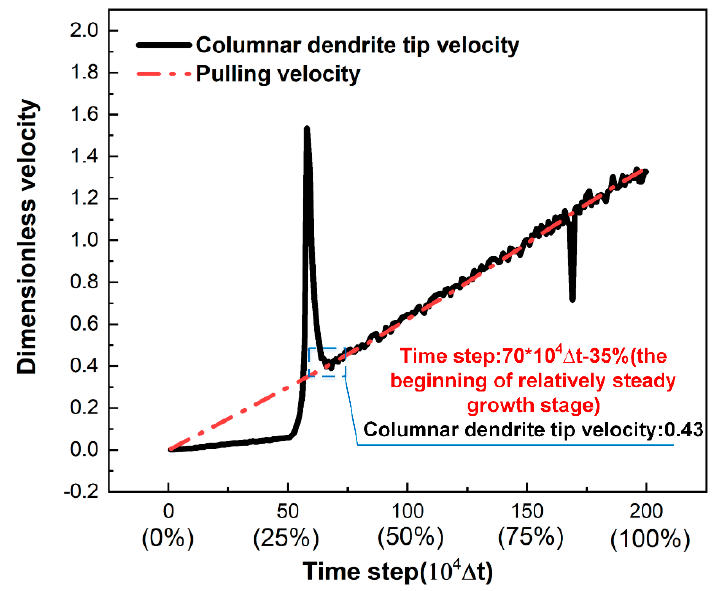
Figure 13. Columnar dendrite tip velocity evolution without CET.